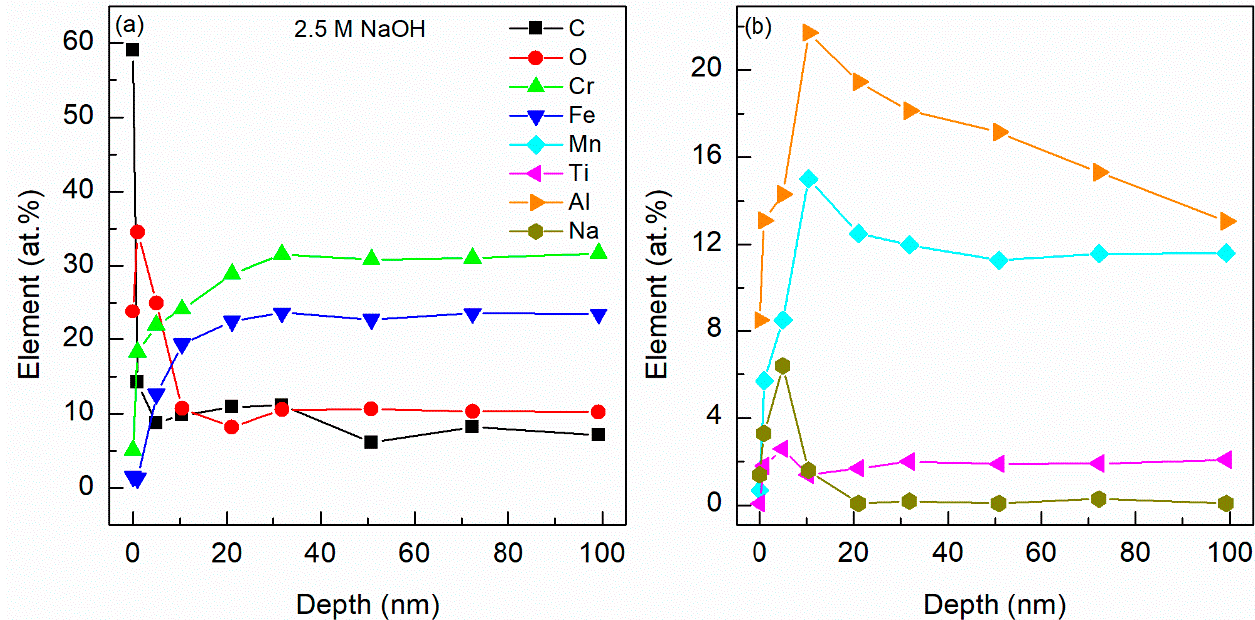
Figure 7. XPS showing depth profiles and elemental analysis (at.%) for Al 10 Cr 30 Fe 25 Mn 30 Ti 5 HEA in 2.5 M NaOH: ( a ) C, O, Cr, Fe, and ( b ) Mn, Ti, Al, and